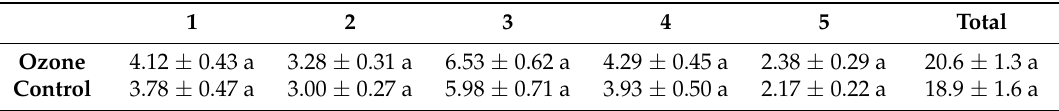
Table 2. Effect of ozone treatment on main bitter taste chemical compounds (mg kg –1 dw) in Radicchio rosso di Treviso tardivo.